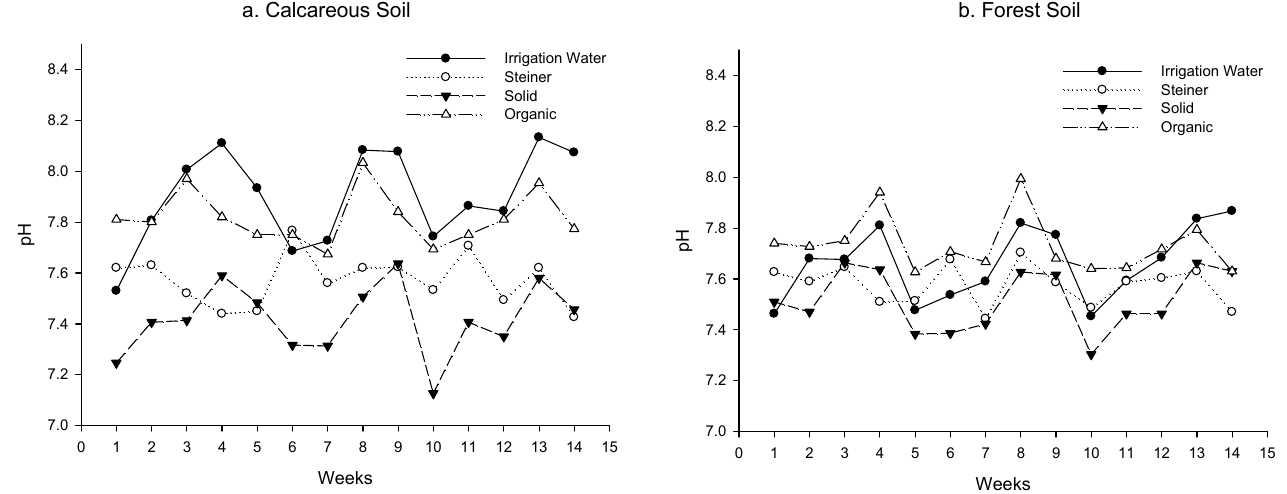
Figure 3. pH dynamics, determined in soil solution samples for calcareous ( a ) and forest soils ( b ), under pot and greenhouse conditions under different nutrient supply scenarios, using inorganic fertilizers: nutrient solution (Steiner) and fertilizers in fractional form (solid) and organic fertilizer with vermicompost tea (aqueous extract).